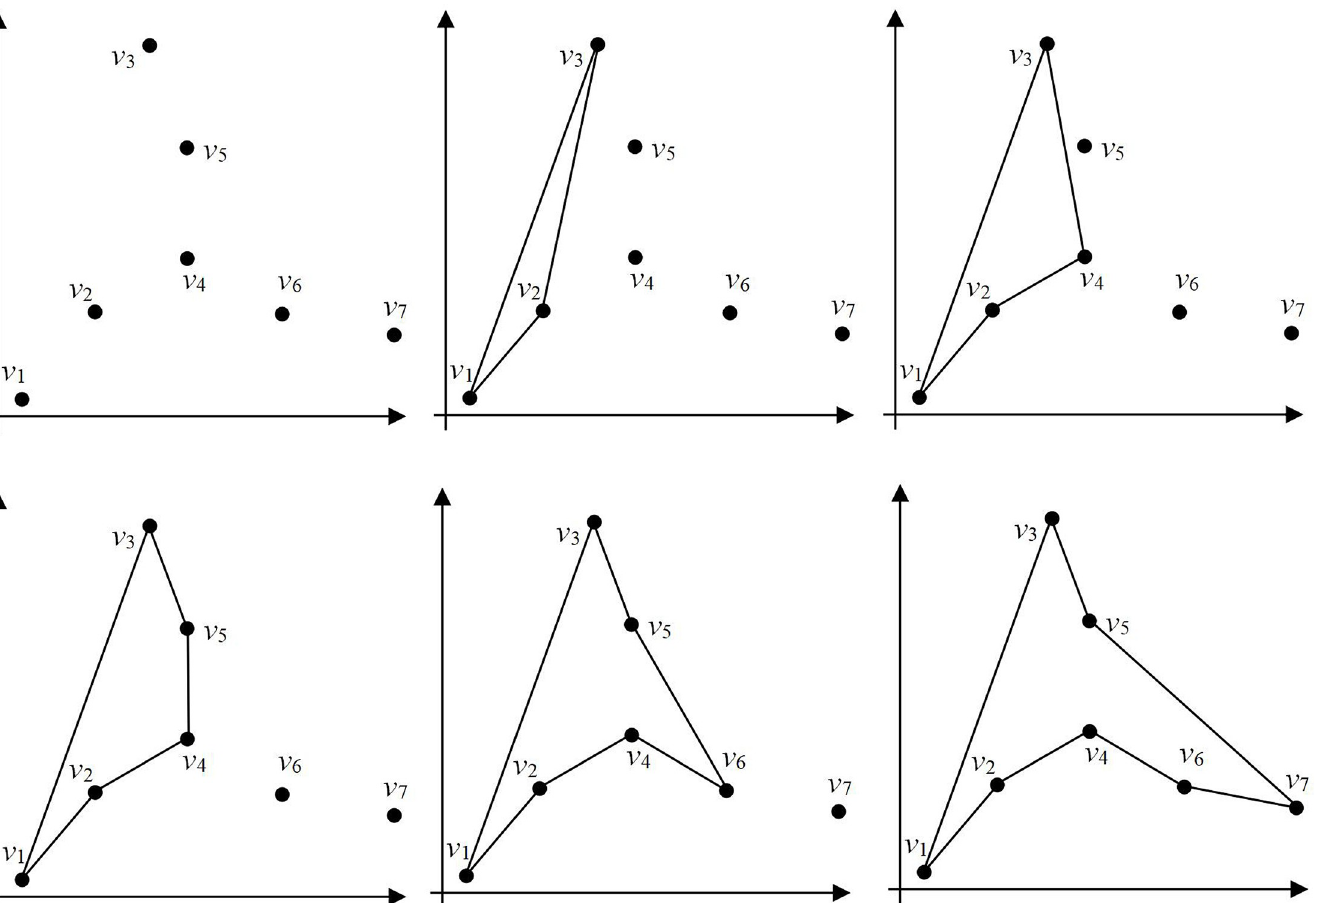
Fig 16. Polygon generation using the proposed method. (a) Random point distribution, (b) polygon initialization, (c) result of one iteration, (d) result of two iterations, (e) result of three iterations, and (f) the final polygon. https://doi.org/10.1371/journal.pone.0230342.g016 PLOS ONE | https://doi.org/10.1371/journal.pone.0230342 March 13,